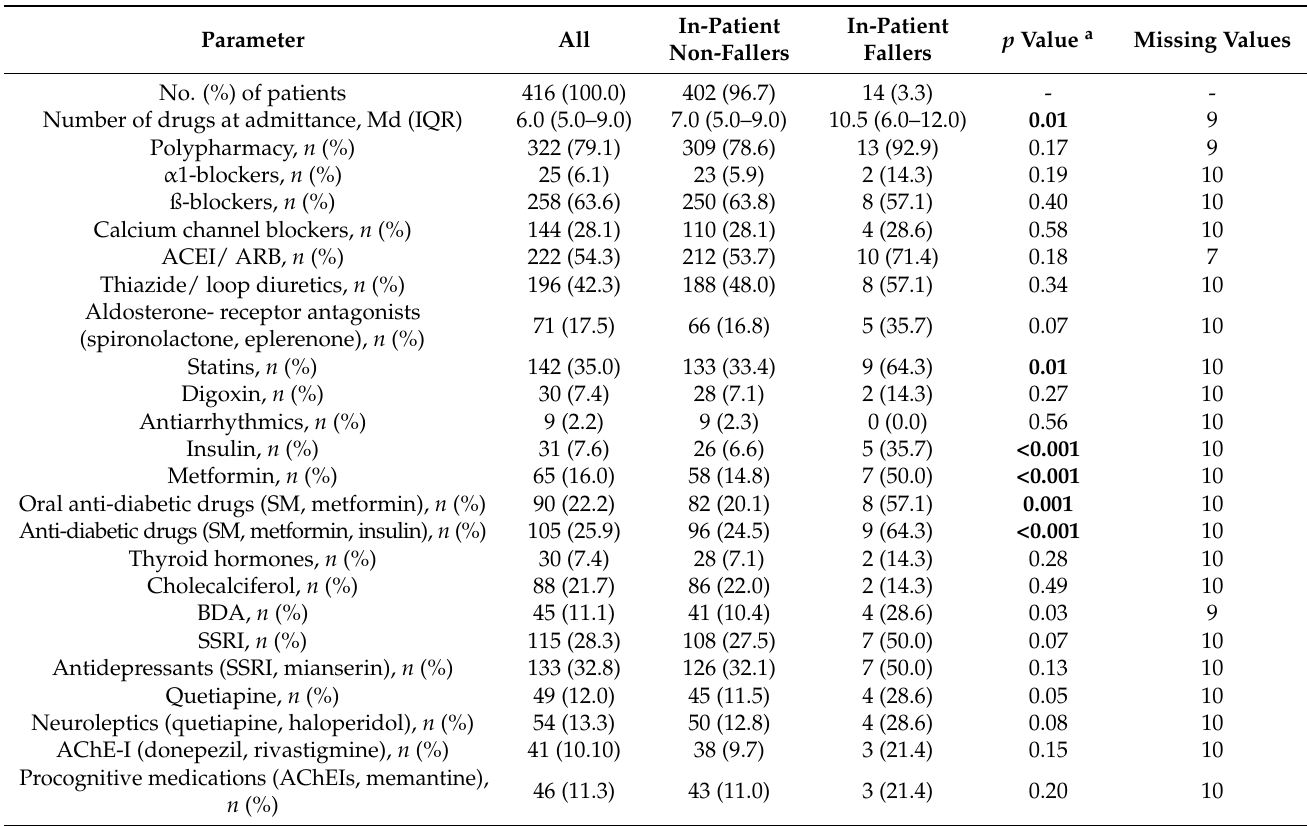
Table 2. Characteristics of study participants—pharmacotherapy correlates of